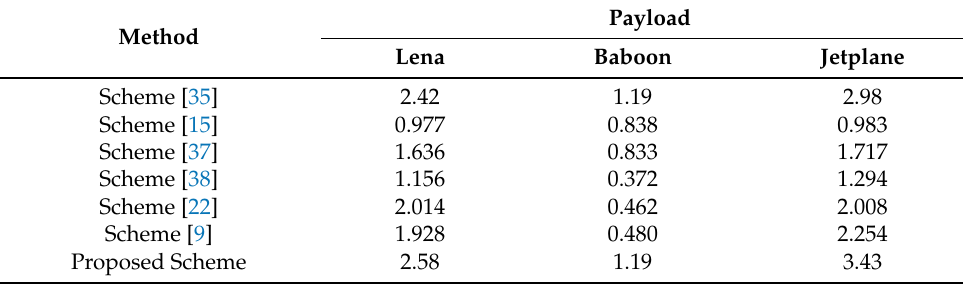
Table 3. Comparison of payload on three